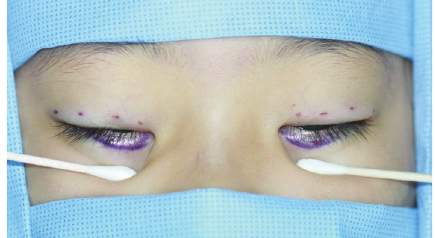
Figure 2: The photography showing the marking of the upper lid sutures placement and the lower lid incision.